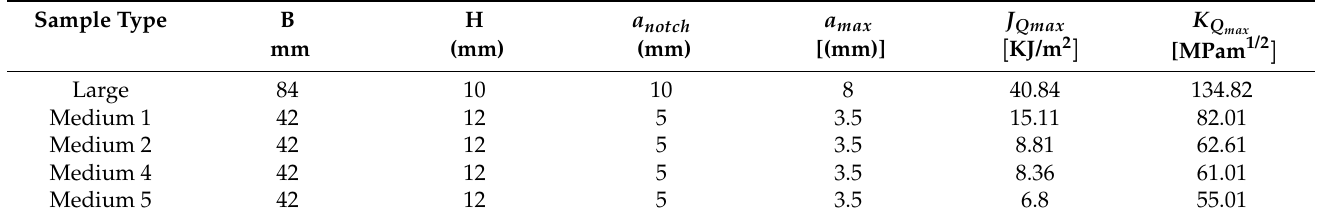
Table 3. Data for ASTM1820